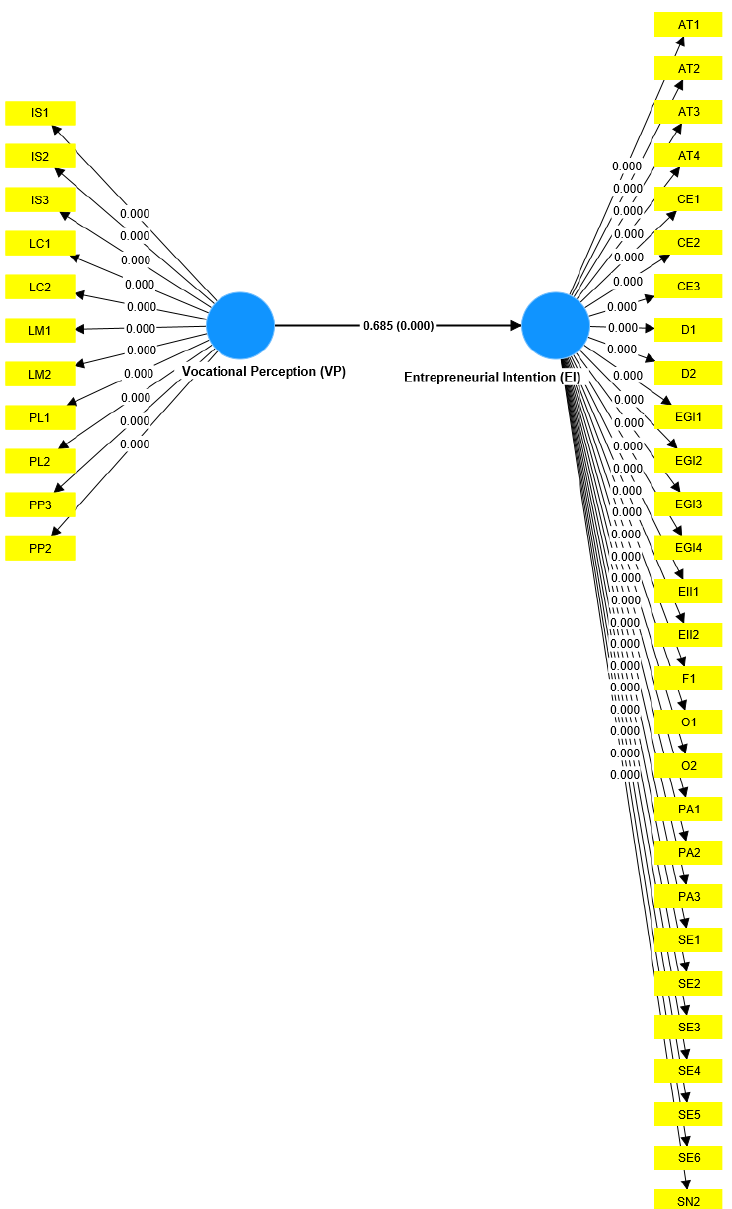
Figure 4: Hypothesis Testing, Source: